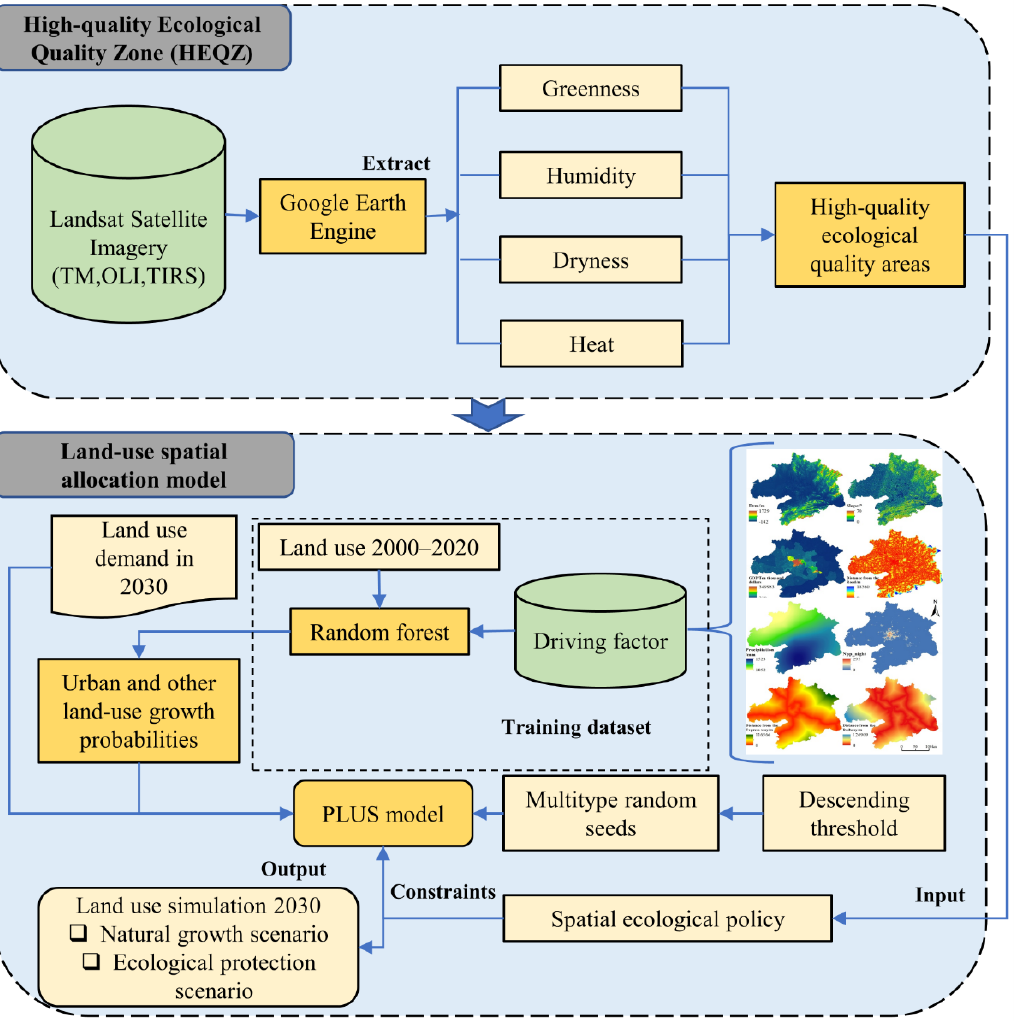
Figure 2. Identification of high-quality ecological areas in the WUAA and framework of land-use simulation (Abbreviations: TM, Thematic Mapper; OLI, Operational Land Imager; TIRS, Thermal Infrared Sensor; PLUS, Patch-generating Land Use Simulation).